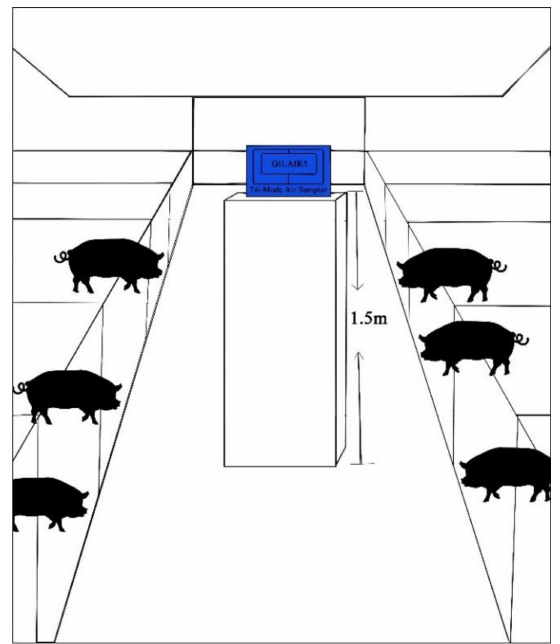
Figure 1. The location of air sampler in the swine confinement